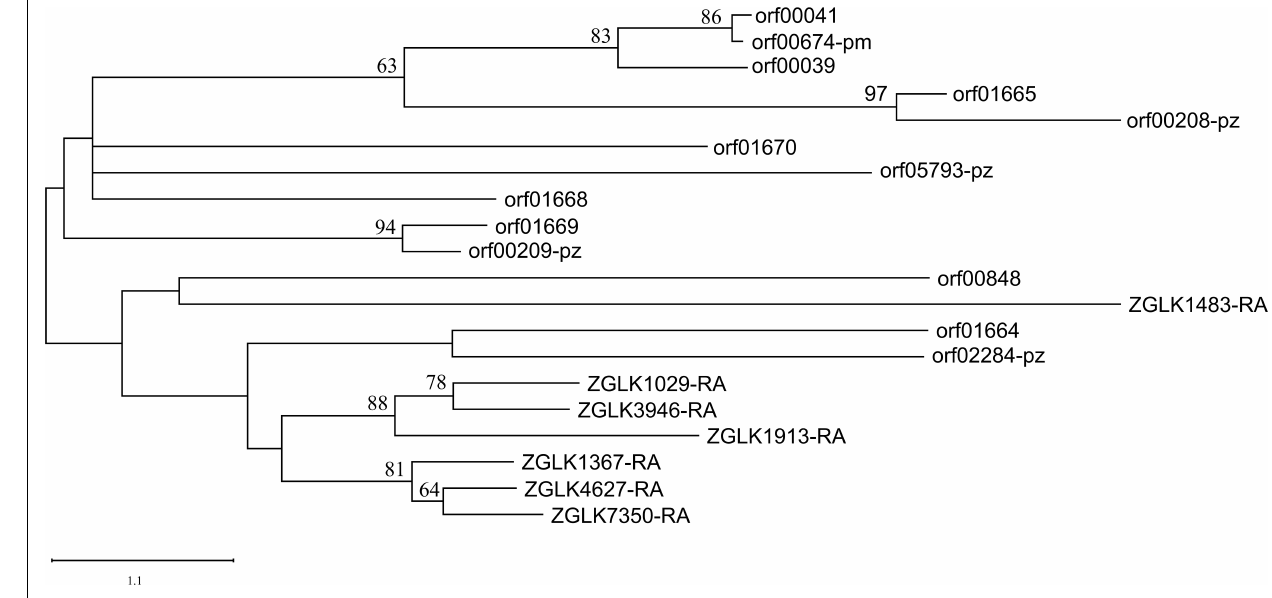
Frontiers in Microbiology |